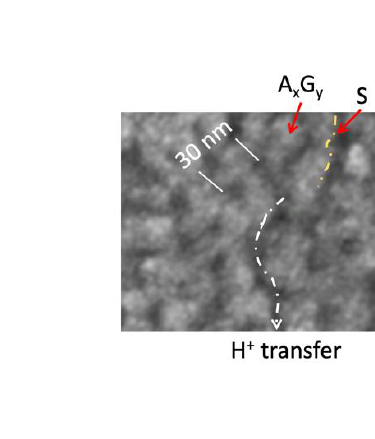
Figure 11. FE-SEM images of the three A x G y S-10 cross-linked diblock membranes.